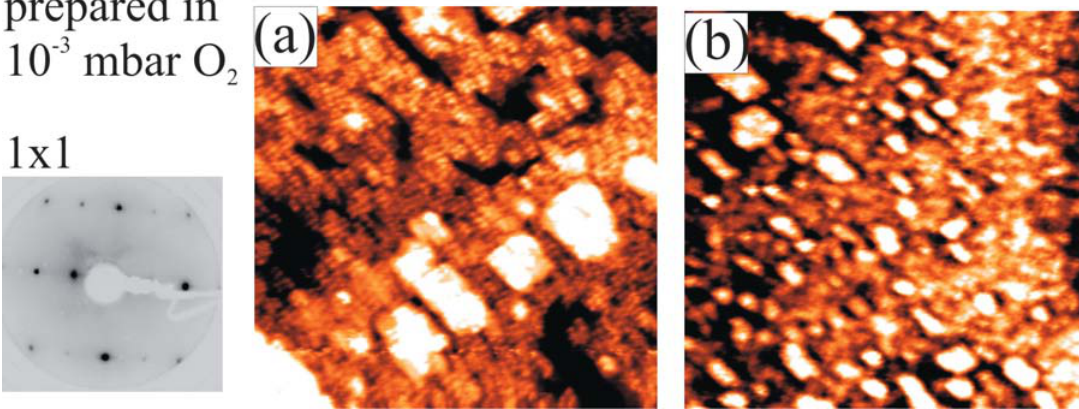
Figure 4 . LEED pattern and STM images of SnO (110) surfaces prepared by (a) annealing in 10 -3 2 mbar O and (b) after subsequent annealing to 800 K in vacuum. The scan area of the STM images is 2 100x 100 nm 2 . (reproduced with permission from ref.